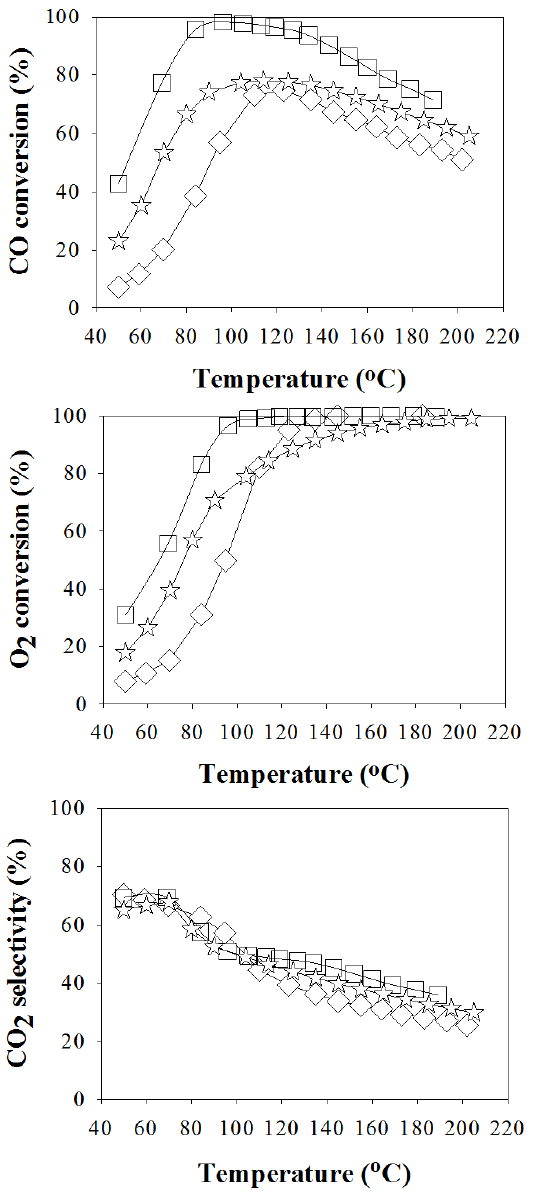
Figure 1. CO-PROX performance of Au/La 2 O 3 /Al 2 O 3 (S35) (□), Au/La 2 O 3 /Al 2 O 3 (S115) ( ☆ ), and Au/La 2 O 3 /Al 2 O 3 (G) ( ⃟ ). Reaction conditions: 1 mol % CO, 1 mol % O 2 , 50 mol % H 2 , and 48 mol % He, F/W = 60,000 mL g cat–1 h –1 . CO-PROX: preferential oxidation of CO in H 2 . Table 1. Particle size of gold in Au/La 2 O 3 /Al 2 O 3 catalysts reduced under different conditions, and their CO-PROX activities. Temperatures Achieving Average Particle Catalyst Reducing Agents a CO Conversions Higher Reference Size of Gold (nm) b than 97% ( ◦ C) c Au/La 2 O 3 /Al 2 O 3 (H) H 2